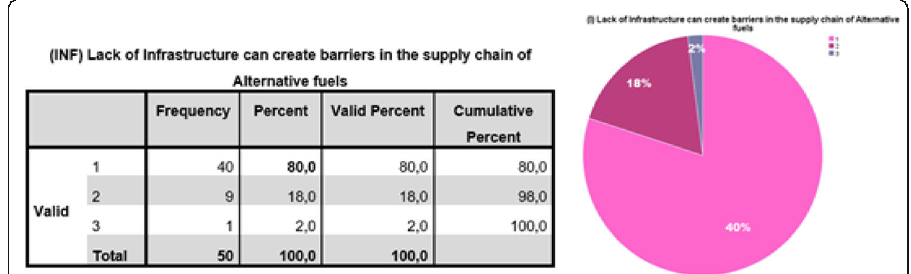
Fig. 3 The lack of infrastructure can create problems in the supply chain of alternative fuels. Source: by